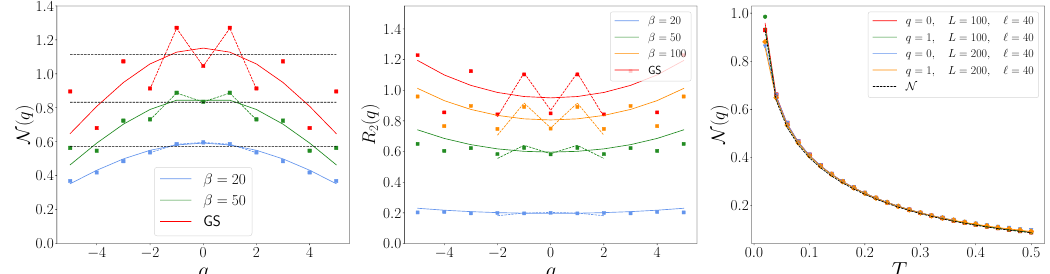
Figure 4: Imbalance resolved negativities for a few different values of q , L = 200, (cid:96) = (cid:96) = (cid:96) = 30, with n → 1 (left-panel) and n = 2 (middle-panel). The dashed e 1 2 black lines are the truly asymptotic result (108) showing equipartition, while the solid lines include the first correction due to the cutoffs as in Eq. (107). The dashed coloured lines are the ratio between the Fourier transforms without exploiting the saddle point approximation. For small q , the field theory prediction (in which the lattice cutoffs are included) well describes the numerical data. In the right-panel, (cid:96) = 40 is fixed, we report two system sizes and two values of q and plot function of T . The coloured lines are Eq. (107) while the dashed one represents Eq. (108). The plot confirms the equipartition of negativity. Moreover, for large T , becomes a universal function of π(cid:96) T